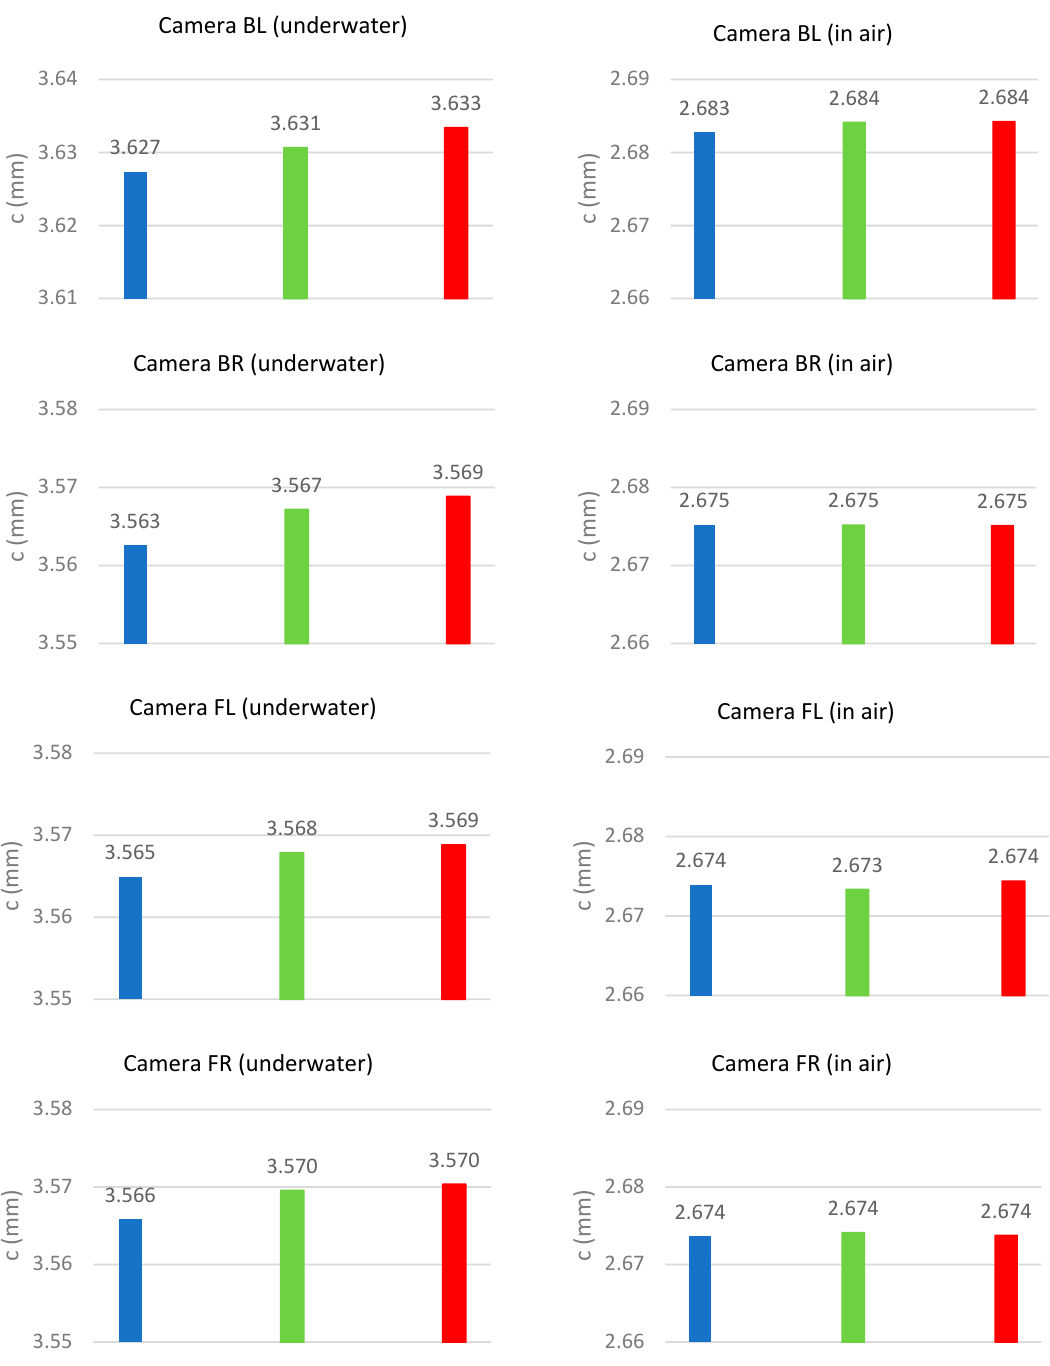
Figure 4. Comparison of the CMB calculated principal distances for the four different cameras (rows) in the underwater ( left column) and the in-air environment ( right column). The order in all diagrams is blue band, green band and red band (indicated by colour). Table 5. Principal distances and their standard deviations from the CMB adjustments.